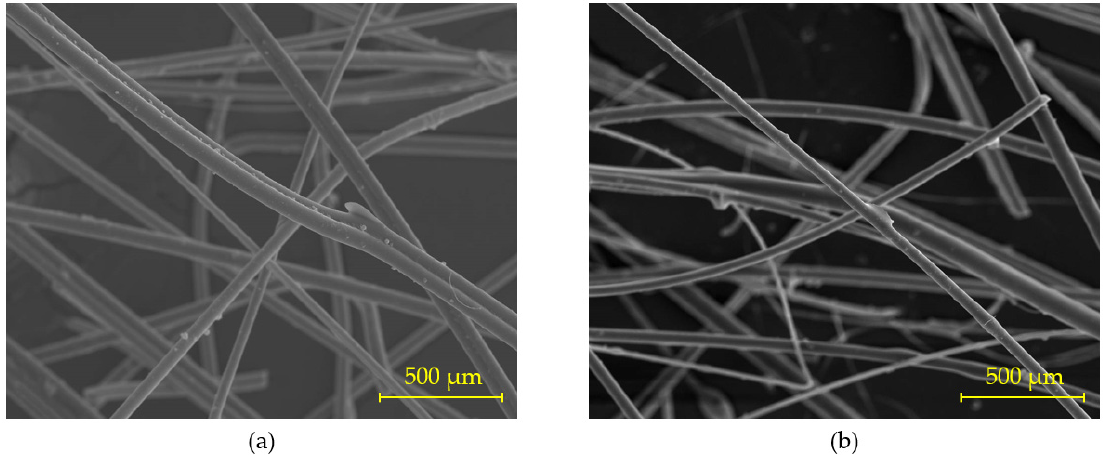
Figure 3. Electron microscopy for recycled fibres obtained by secondary electron imaging: ( a ) rock wool fibre and ( b ) glass wool fibre.